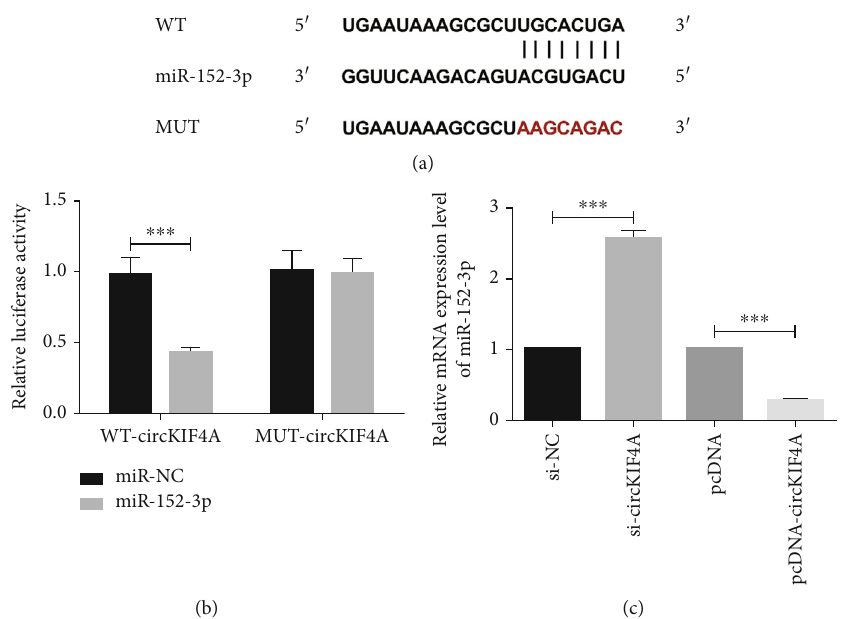
Figure 5: circKIF4A targets miR-152-3p a: Complementary sequences of miR-152-3p and circKIF4A. b: Double luciferase reporter assay. c: circKIF4A regulation of miR-152-3p. ∗∗∗ P <